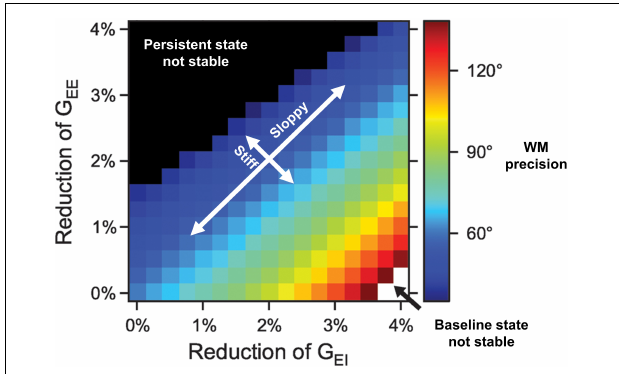
FIGURE 1 | Working memory (WM) precision as a function of excitation/inhibition balance (adapted from Murray and Wang, 2018). NMDAR conductance strengths onto pyramidal (G EE ) and inhibitory cells (G EI ) are depicted along the y- and x-axes, respectively. Iso-contour lines span positive slope directions, along which E/I ratios are associated with equivalent spatial WM precision despite changes in the absolute conductances. Optimal performance results in the region around the diagonal. Such a “sloppy” axis defines a regime where significant changes in conductance parameters values still preserve E/I ratios and WM performance. This contrasts with a “stiff” axis over which even modest E/I balance changes result in significant changes in WM performance. Along this stiff axis, poor WM performance arises from one of two ways: a relative defect of excitation by pyramidal cells onto other pyramidal cells (unstable persistent state; upper left of plot) or onto inhibitory interneurons, resulting in widespread excitation (unstable baseline state translating to representations of all spatial locations being indiscriminately activated; lower right of plot). Thus, with poor performance at either extreme of this “stiff” axis, we see WM performance can be a non-linear, inverted-U function of E/I